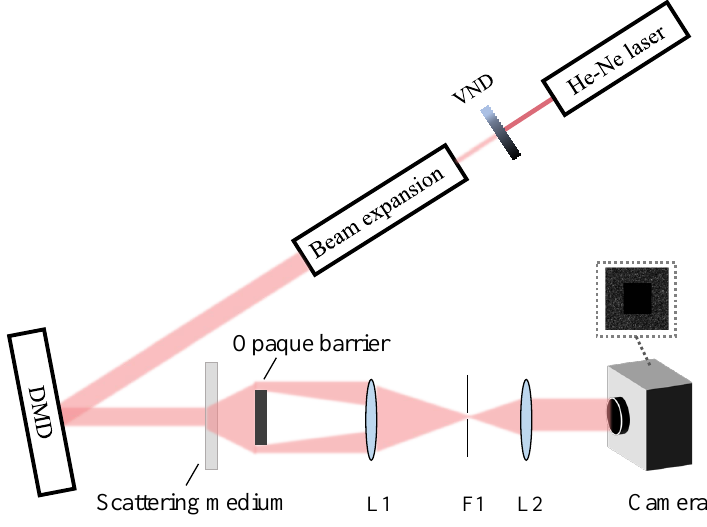
Figure 3. Detailed experimental setup. (VND: variable neutral density filter; DMD: digital micro- mirror device; L1: 300 mm lens; L2: 150 mm lens; F1: